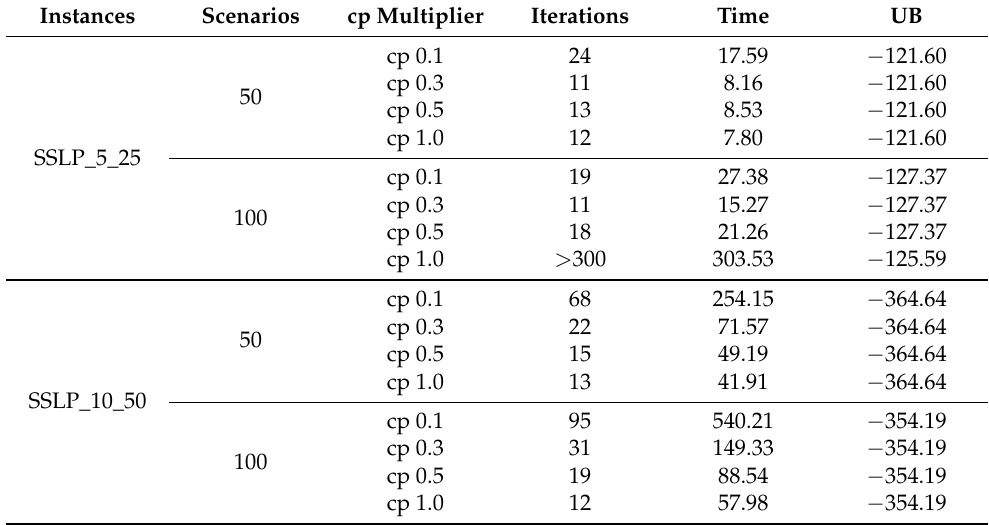
Table A1. Computational results for PySP on